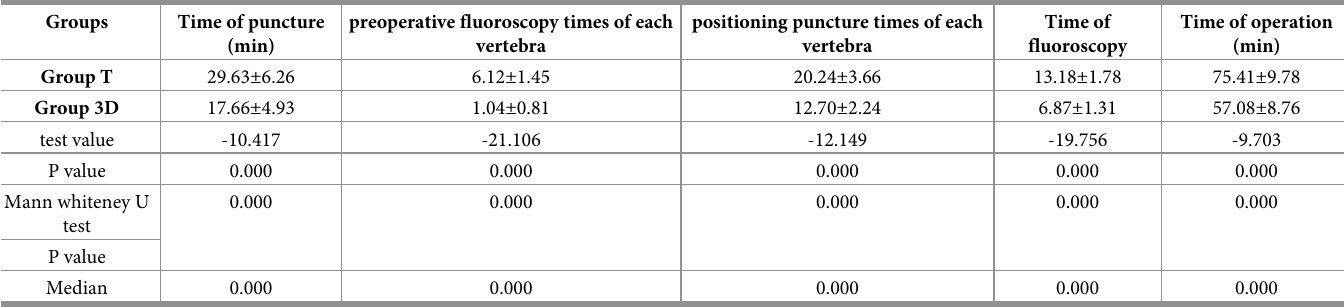
Table 2. Surgery characteristics.